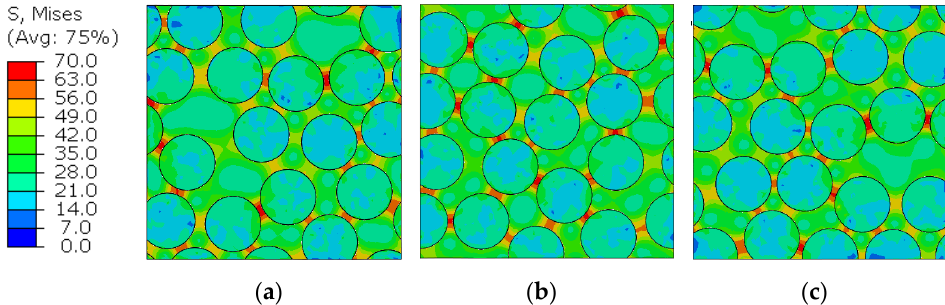
Figure 7. RVE micro-residual von Mises stress distribution for ( a ) RVE1, ( b ) RVE2 and ( c ) RVE3.